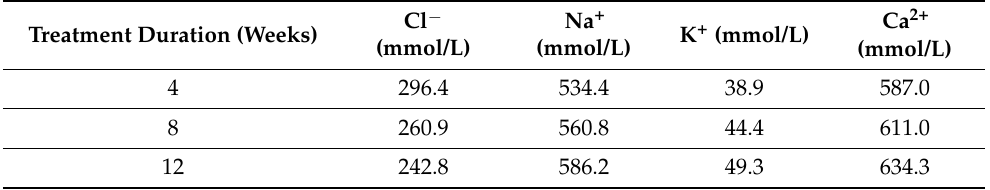
Table 2. Mean ionic concentrations in the vicinity of steel after the electrochemical treatment of different treatment